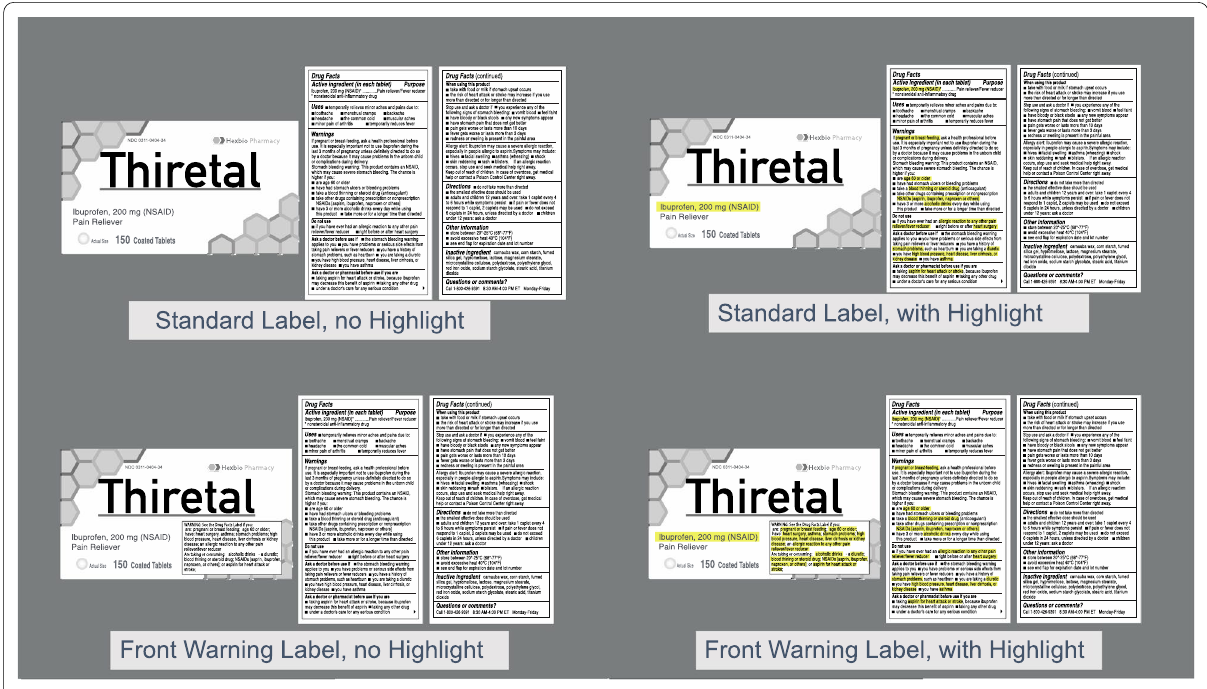
Fig. 2 Examples of the four label